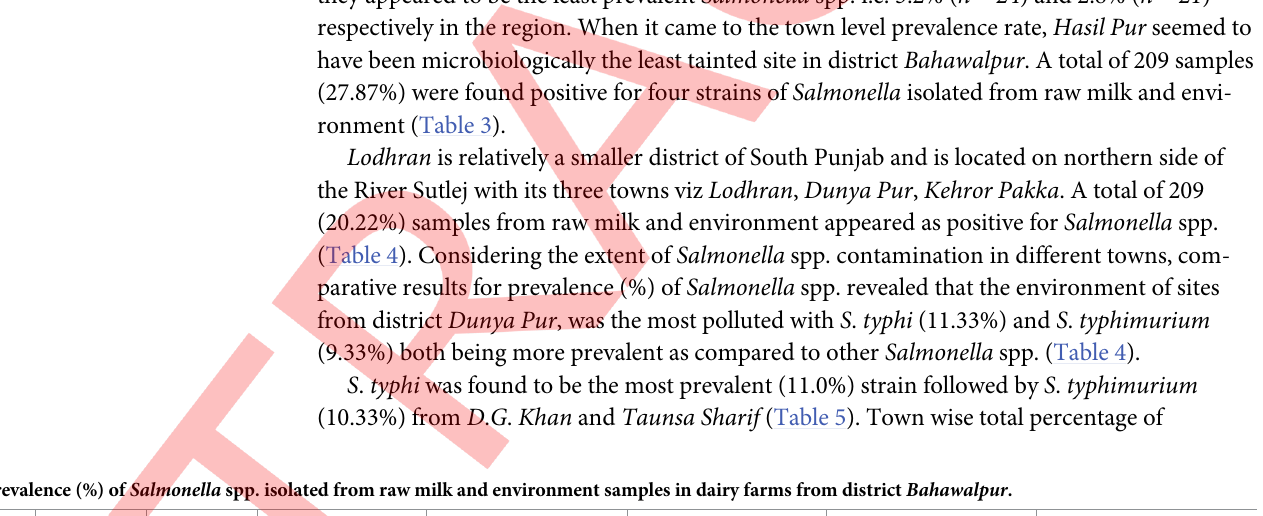
the highest prevalence (%) for all four Salmonella spp. with S . typhi being more visible (Table 3). S . typhi also turned up as the most prevalent Salmonella spp. i.e. 11.8% ( n = 89 ) in Bahawalpur district as a whole, followed by S. typhimurium i.e. 10.0% ( n = 75 ). Notwithstand-